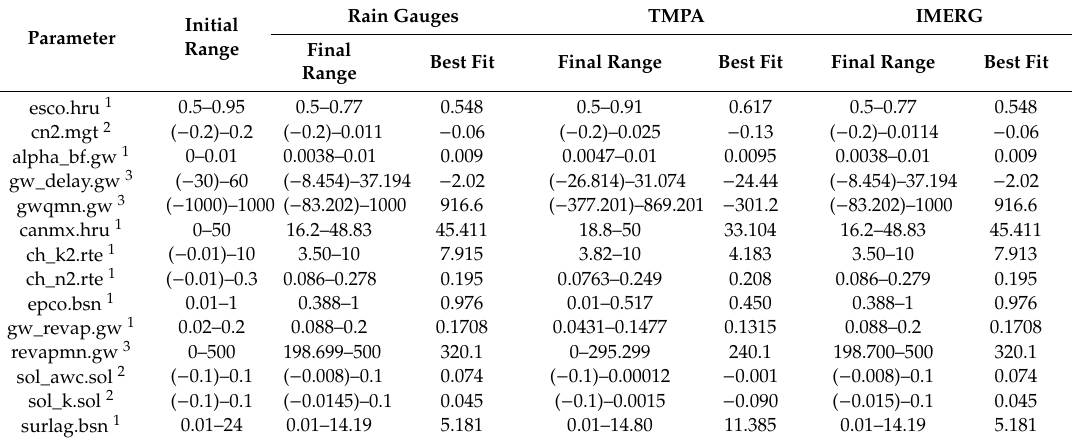
Table 2. Statistical metrics for hydrological and meteorological assessment.